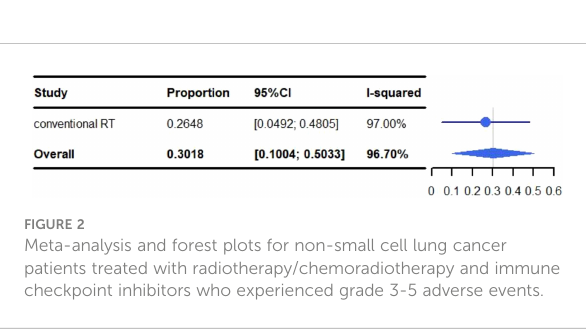
TABLE 2 Non-small cell lung cancer patient survival following treatment with ICIs and RT.